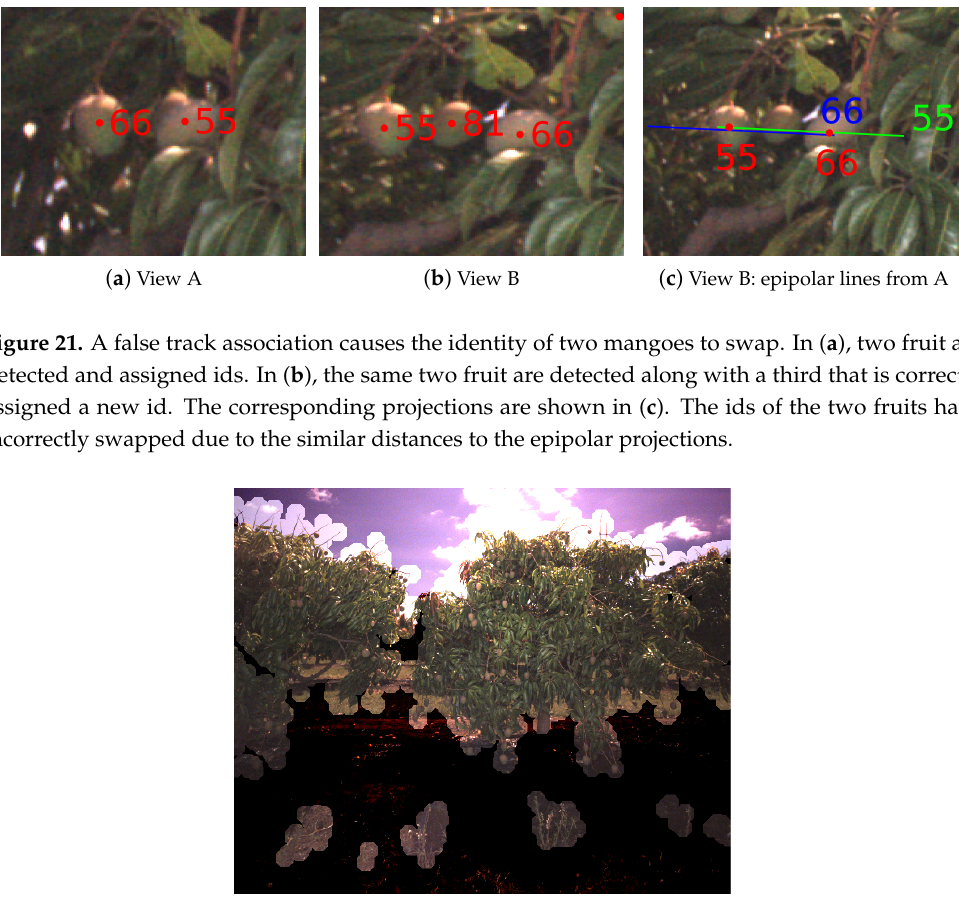
Figure 22. Tall grass (above 20 cm) is retained in the LiDAR data and projected when forming the image mask. Mangoes detected in these regions are likely to have fallen, but will still be